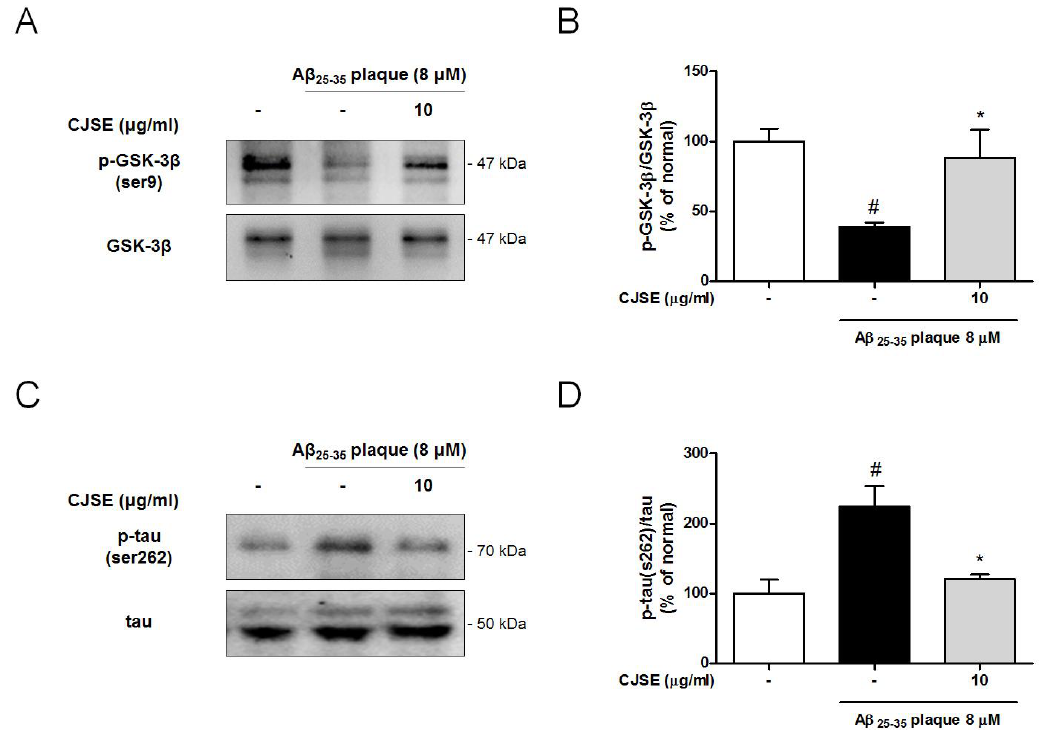
Figure 5. E ff ects of CJSE on the expression of phosphorylated GSK-3 β and phosphorylated tau in mouse primary neuronal culture. ( A , C ) Representative band images of GSK-3 β ( A ) and tau ( C ) expression. ( B , D ) Quantifications of the phosphorylated-form / total form ratios of GSK-3 β ( B ) and tau ( D ). Values are indicated as the mean ± S.E.M. # p < 0.05 compared to the normal group; * p < 0.05 compared to A β -treated